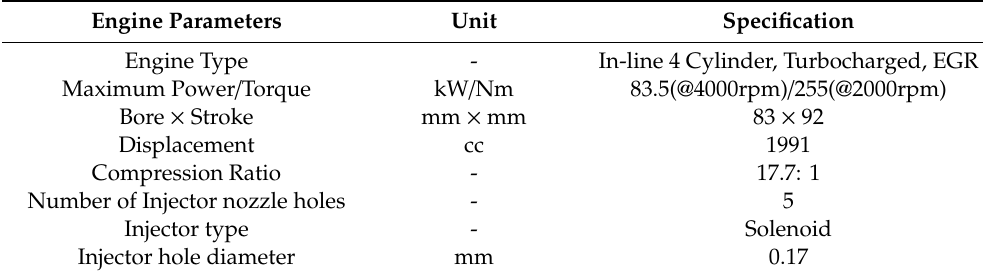
Table 2. Engine specification.